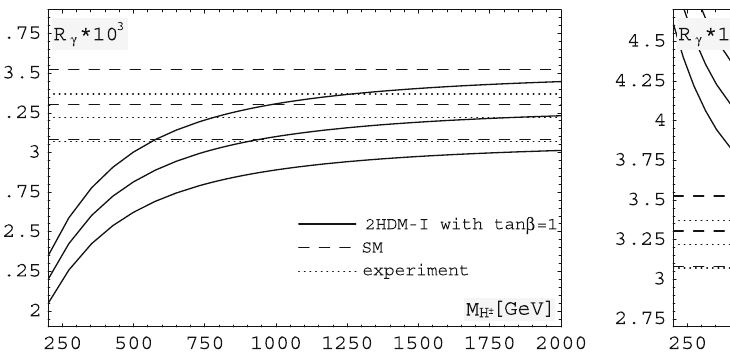
Fig. 2 R γ at E 0 = 1 . 6 GeV as a function of M H ± in Model I with tan β = 1 ( left ) and in Model II with tan β = 50 ( right ). Middle lines show the central values, while the upper and lower ones are shifted